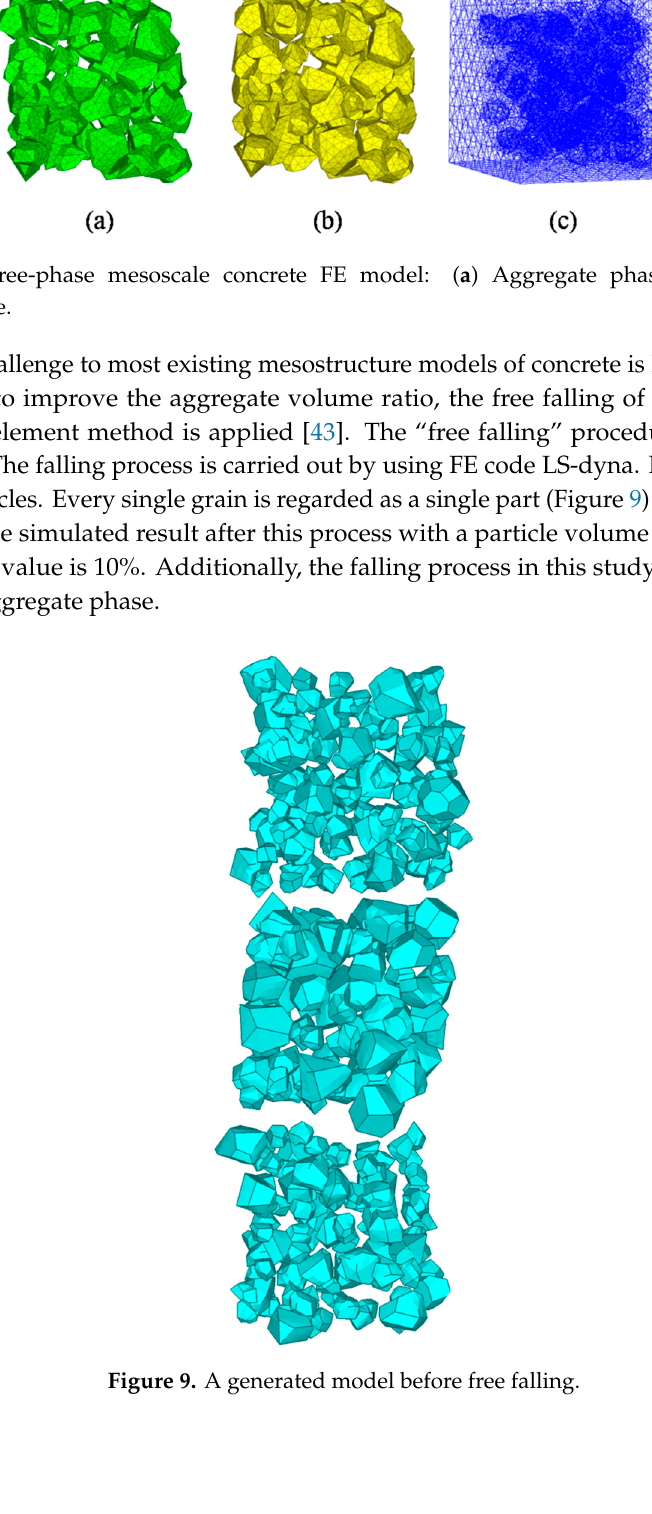
Figure 10. A simulated model after free falling. The surfaces of an aggregate produced by the shrinkage procedure may have a face-to-face feature with the adjacent surfaces of other aggregates. These drawbacks will be overcome after the free falling process. The condition, like a corner of one grain pointing on the surface of another one, showed in Figure 11, is common in realistic concrete specimens.